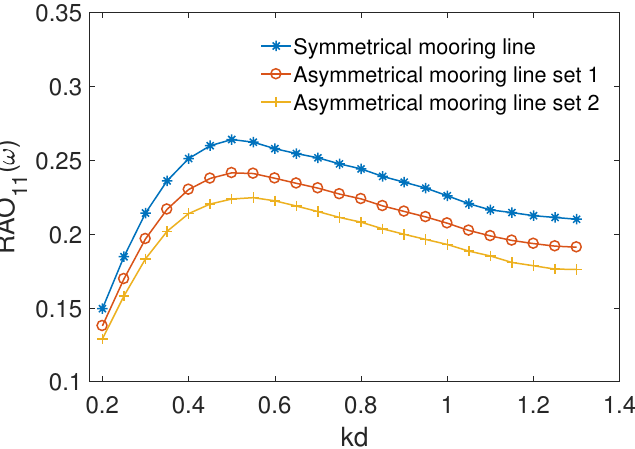
Figure 12. Comparison of the floating body surge motion RAO 11 ( ω ) between symmetrical mooring line condition, asymmetrical mooring line set 1 and set 2.